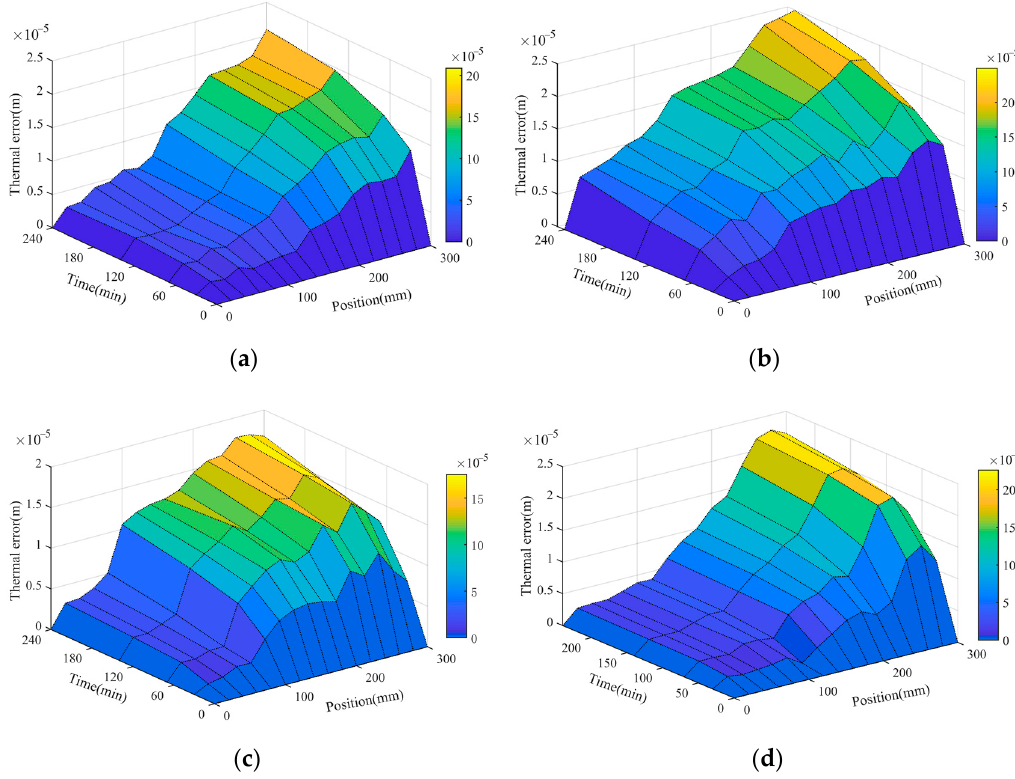
Figure 17. Experimental results of thermal error of ball screw feed system under different working conditions: ( a ) working condition 1; ( b ) working condition 2; ( c ) working condition 3; and ( d ) working condition 4.